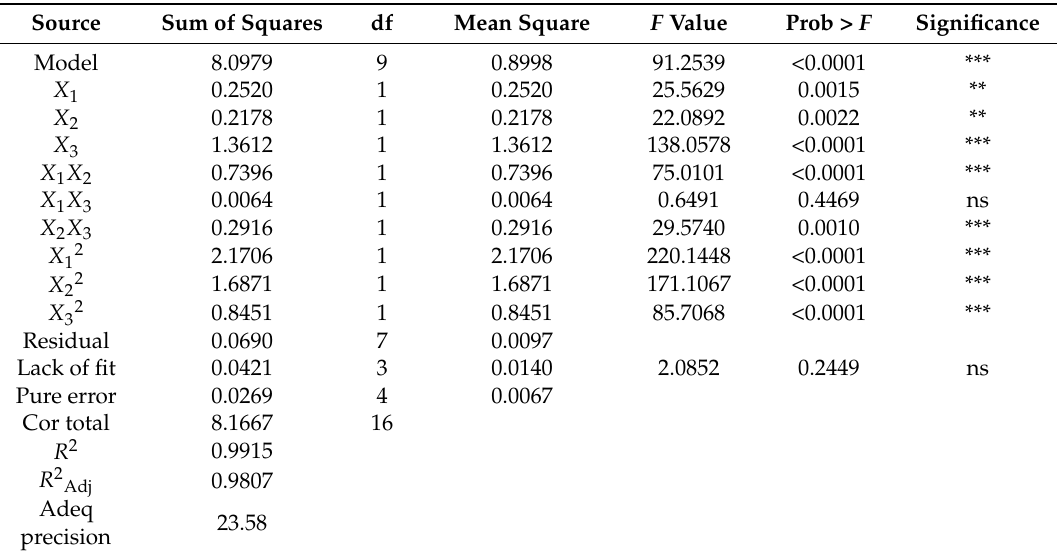
Table 2. Analysis of variance (ANOVA) for response surface quadratic